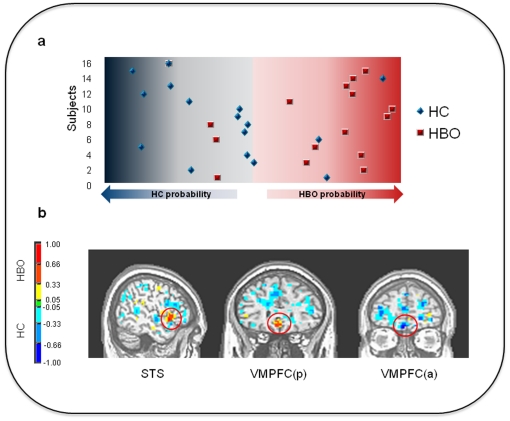
Summary of results from pattern recognition analyses.A. Decision boundary and individual predictive probabilities. B. GPC weights overlaid on an anatomical template. The color code shows the relative weight of each voxel for the decision boundary (red scales: higher weights for healthy bipolar offspring and blue scales: higher weights for healthy controls). The discriminating pattern included clusters with higher weights for healthy bipolar offspring in the superior temporal sulcus (STS; x, y, z: -50, 11, -5) and in a posterior region of the ventromedial prefrontal cortex (VMPFC(p); x, y, z,: 0, 29, -14) and a cluster with higher weights for healthy controls in the anterior region of the ventromedial prefrontal cortex (VMPFC (a); x, y, z: -2, 51, -19) (x, y, z, are in Talairach coordinates).